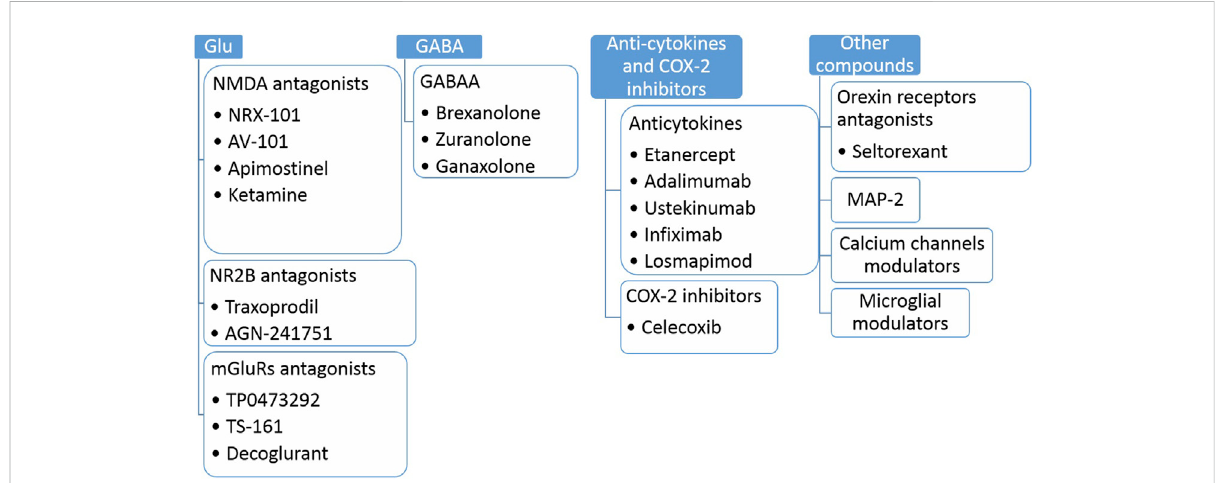
FIGURE 3 Selected examples of antidepressant compounds in clinical trials (Phase I-IV). Glu, glutamate; NMDA, N-methyl-D-aspartate; NR2B, NMDA receptor subunit 2B; mGluRs, metabotropic glutamate receptors, GABAA, gamma-aminobutyric acid receptors A; COX-2, cyclooxygenase 2; MAP- 2, microtubule-associated protein 2.